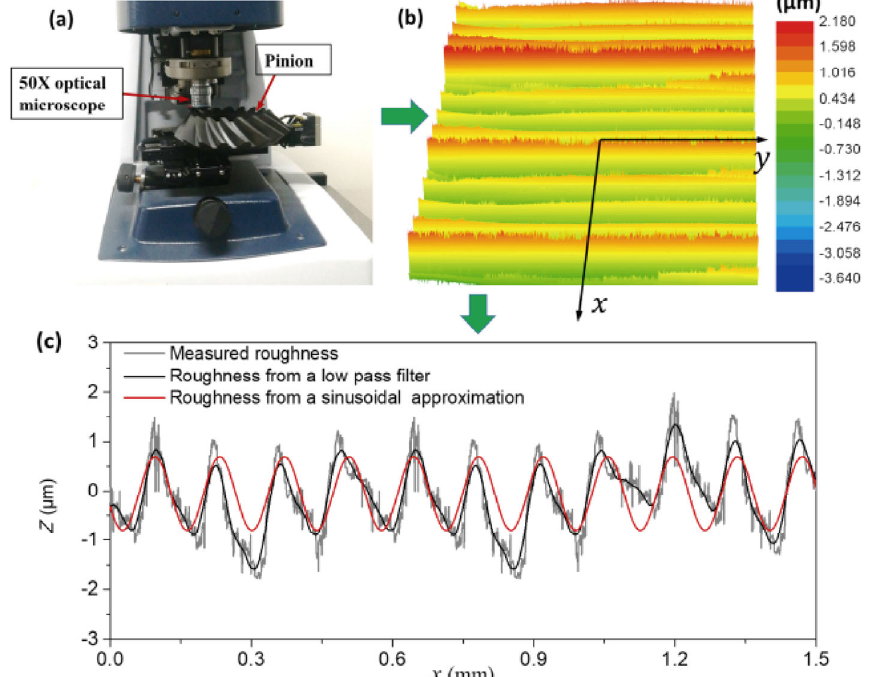
Fig. 3 Measurement of flank roughness in spiral bevel gears: (a) mounting of the pinion on the optical microscope, (b) measured surface roughness, and (c) sinusoidal approximation of